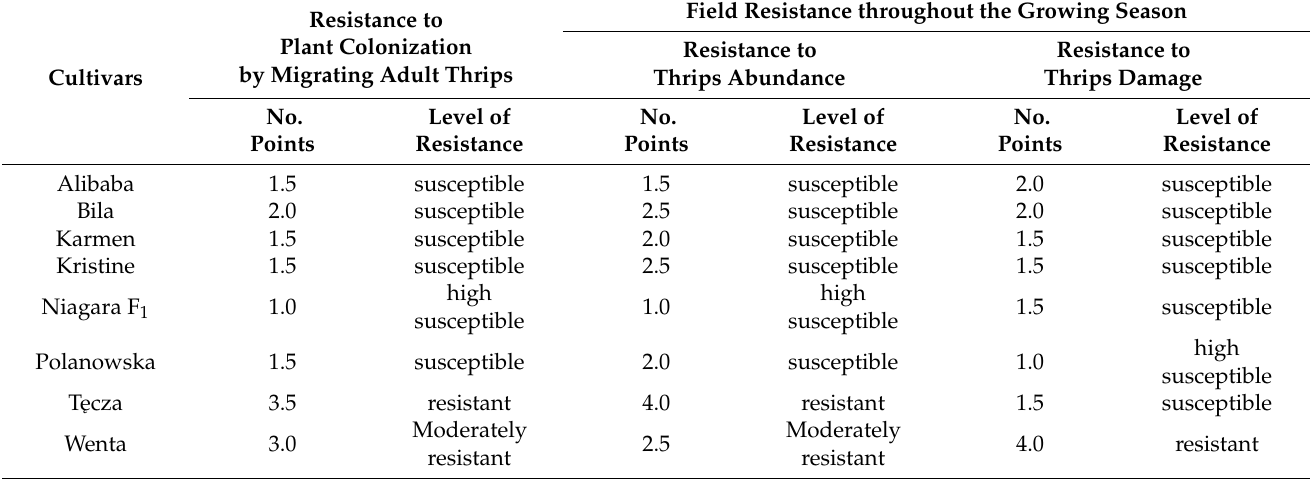
Table 2. Level of resistance of eight onion cultivars to Thrips tabaci